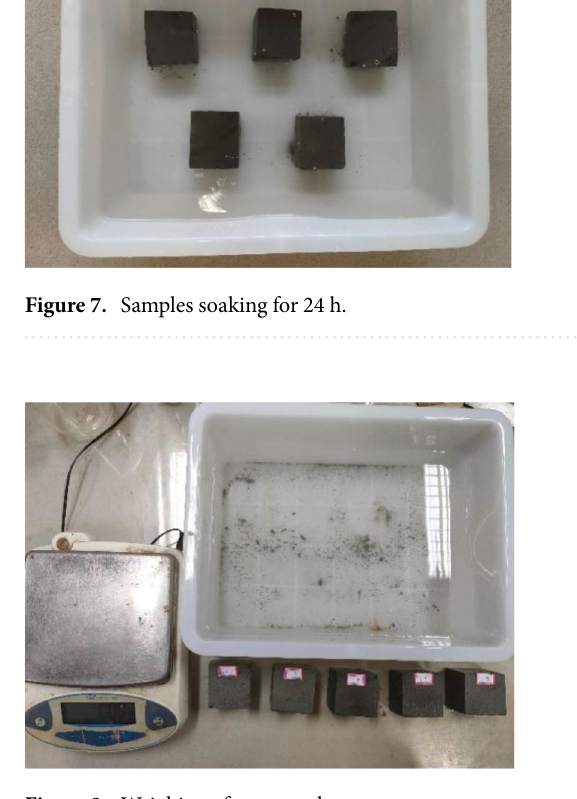
Figure 8. Weighing of test